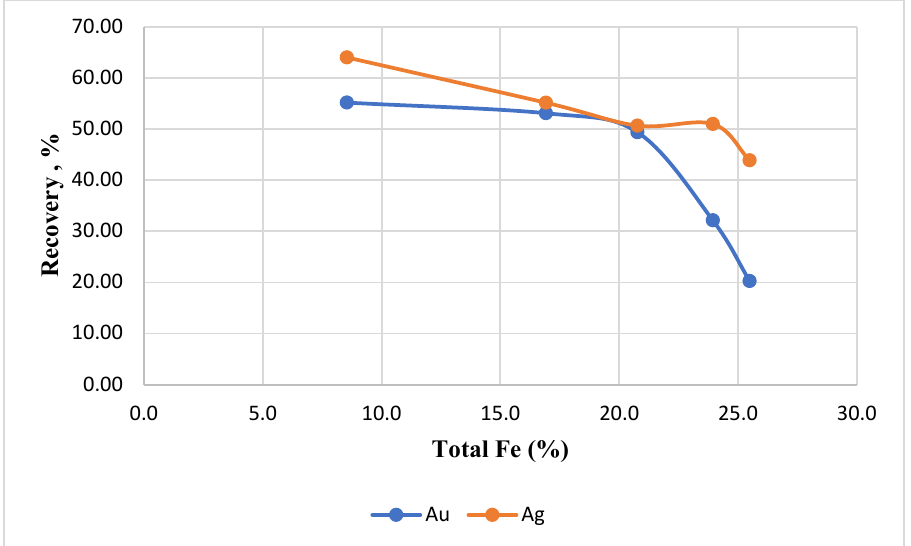
Figure 9. Gold recovery as a function of pretreatment acid concentration.